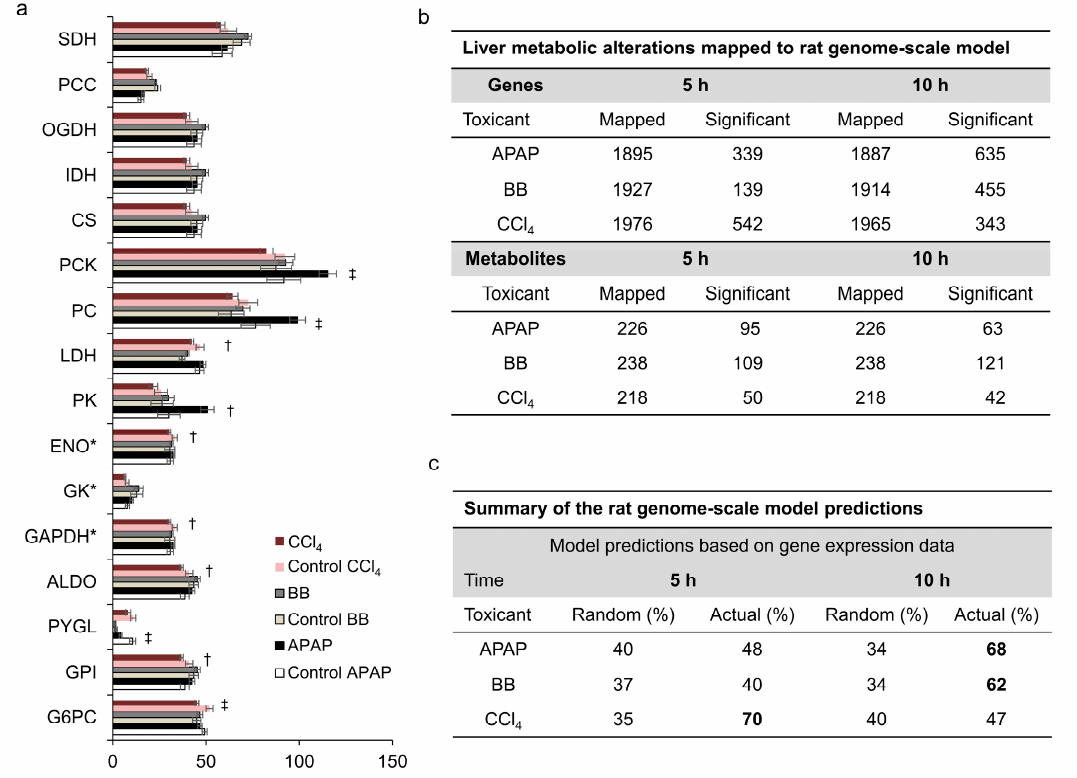
Figure 7. Absolute hepatic flux changes induced by either APAP, BB, or CCl 4 , and metabolic network predictions of metabolite-level changes based on the measured liver gene expression values. ( a ) Bar graphs of flux measurements calculated from metabolic flux analysis 10 h after treatment with either APAP (black), BB (dark grey), or CCl 4 (maroon) compared to their vehicle groups (white, light grey, or pink, respectively). Abbreviations: ALDO, aldolase; CS, citrate synthase; ENO, enolase; GAPDH, glyceraldehyde-3-phosphate dehydrogenase; GK, glycerol kinase; GPI, D-glucose-6-phosphate isomerase; G6PC, D-glucose-6-phosphatase; IDH, citrate dehydrogenase; LDH, lactate dehydrogenase; OGDH, oxoglutarate dehydrogenase; PC, pyruvate carboxylase; PCC, propionyl-CoA carboxylase; PCK, phosphoenolpyruvate carboxykinase; PK, pyruvate kinase; PYGL, glycogen phosphorylase; SDH, succinate dehydrogenase ( ‡ p < 0.05, † 0.05 < p < 0.1, and * value in Hexose units). ( b ) Summary of the total and significantly altered liver genes (FDR < 0.1) and plasma metabolites mapped to the rat metabolic network model. ( c ) Summary of predictions for changes in plasma metabolite levels based on changes in liver gene expression.